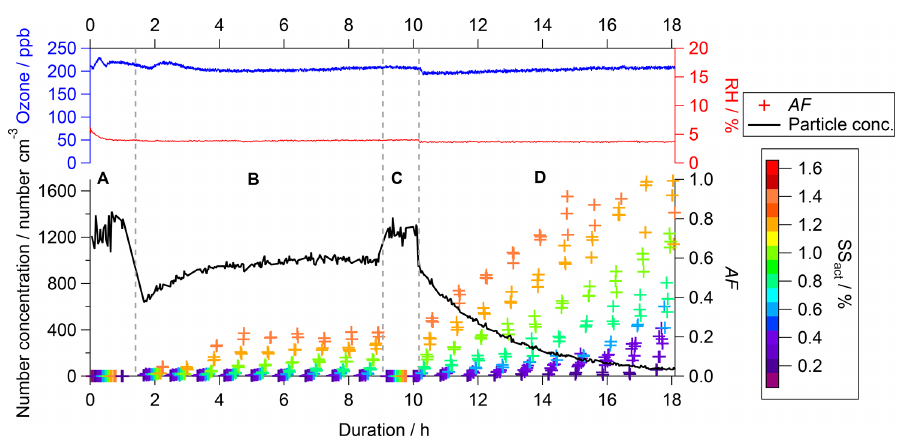
Figure 2. Example of data of the CCN activity (colored crosses, right bottom axis), particle number concentration (black line, left bottom axis), O 3 concentration (blue line, left top axis), and RH (red line, right top axis) as a function of experimental duration (bottom axis). The crosses presenting the CCN activated fraction (AF) are color-coded by the SS as indicated in the color scale on the right. The labels A (bypass), B (filling), C (bypass), and D (flushing) indicate specific periods within the experiment.